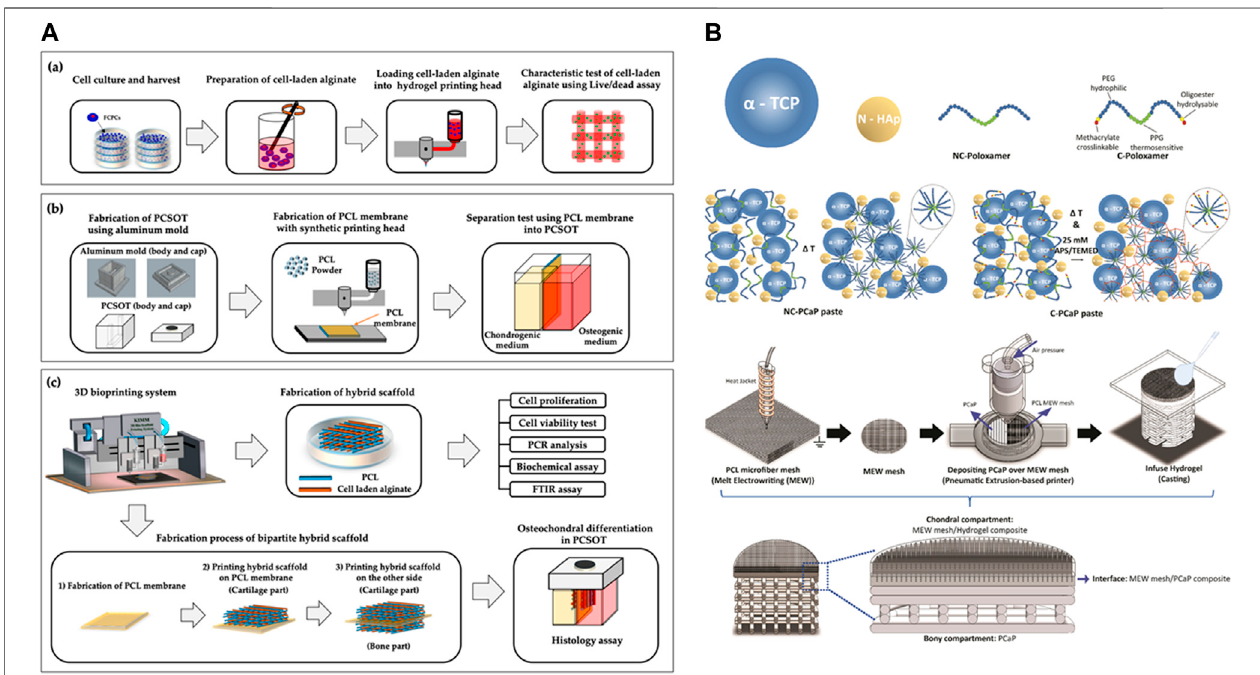
FIGURE 6 | Representative design scheme of bi-layered and multi-layered scaffolds. (A) Polycaprolactone (PCL)/alginate bi-layered scaffold. Reproduced with permission (Yu et al., 2020). Copyright: © 2020 by the authors. (B) A multi-layered scaffold with bone layer (PCaP) connects with chondral layer (PCL) by the melt electrowriting mesh. Reproduced with permission (Diloksumpan et al., 2020). Copyright: © 2020 by the